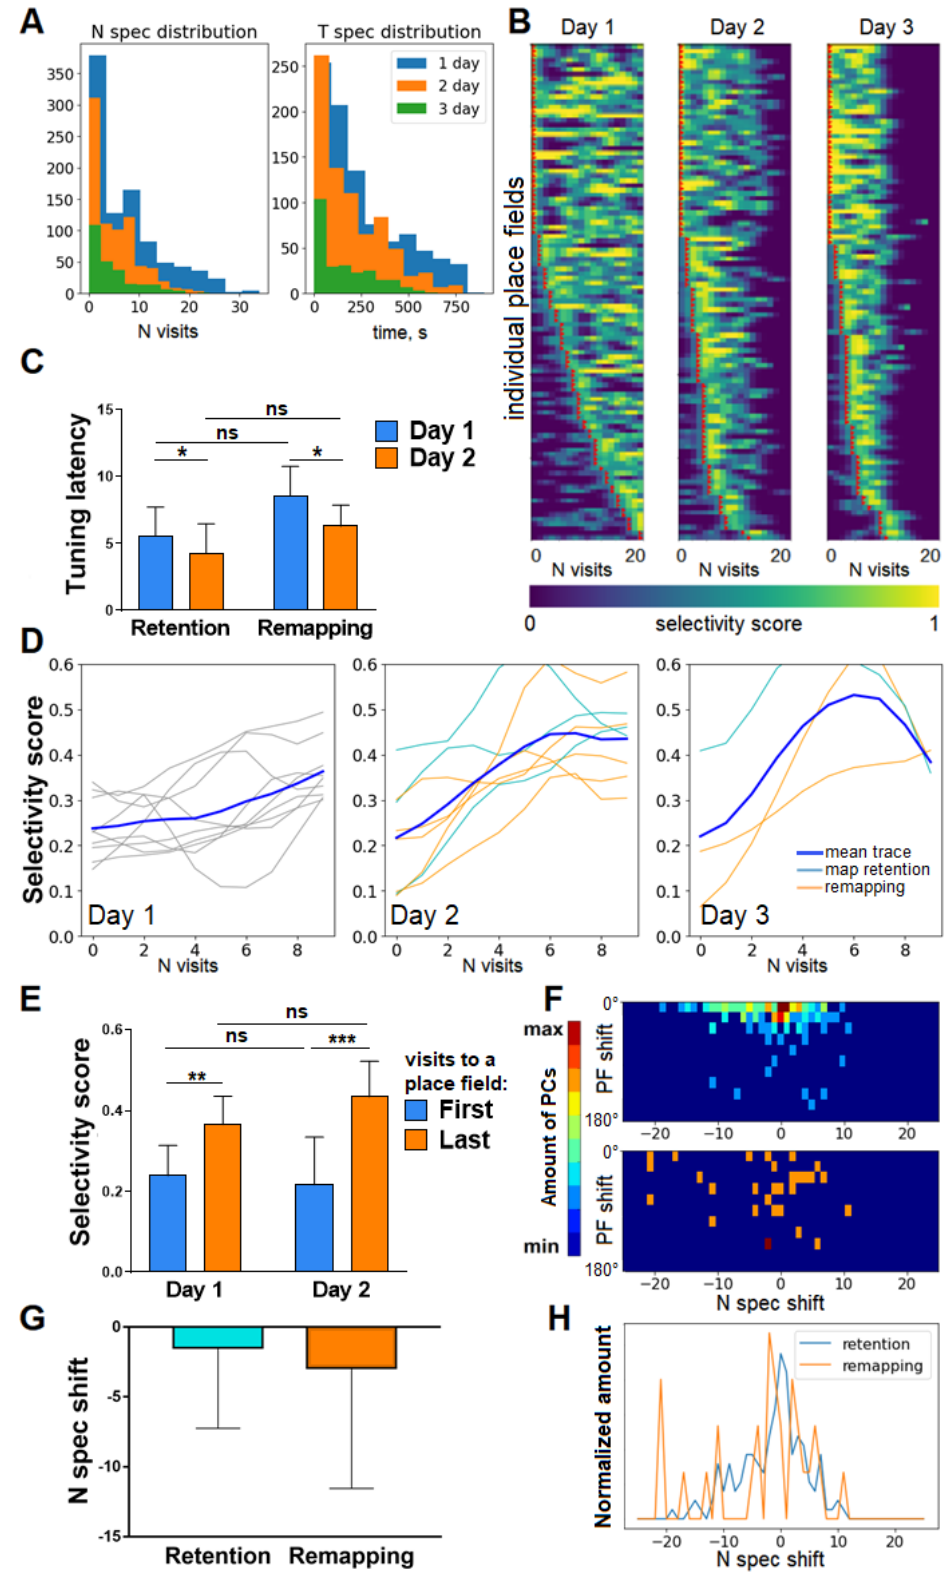
Figure 4. ( A ). Distribution of tuning latency both in the number-of-visits domain and in the time domain. ( B ). Sample of selectivity score distribution in one individual mouse on three consequent days (place fields are sorted independently for each session). Red triangles denote the number of visits where the specialization occurred (n_spec). ( C ) Tuning latency significantly decreases on the second day, while